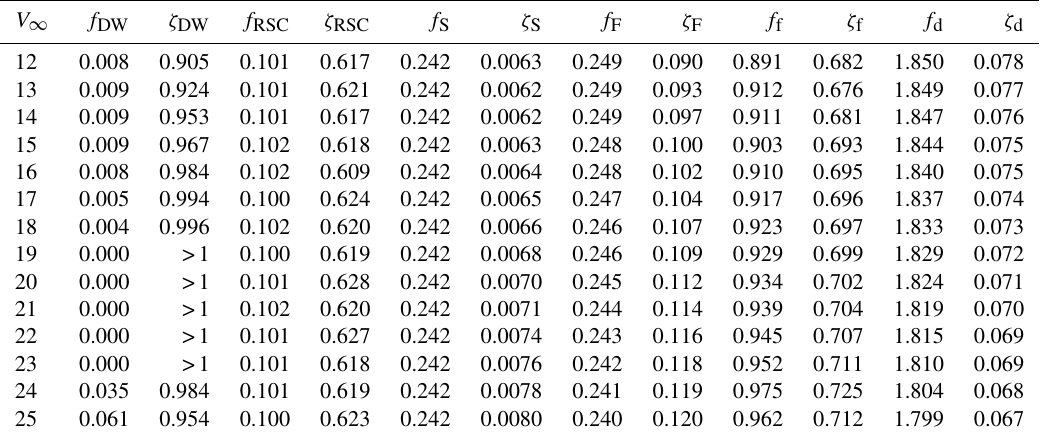
Table 5. Modal frequency and damping properties of the pole-placement tuning. For abbreviations, including subscripts, please see the table in Appendix